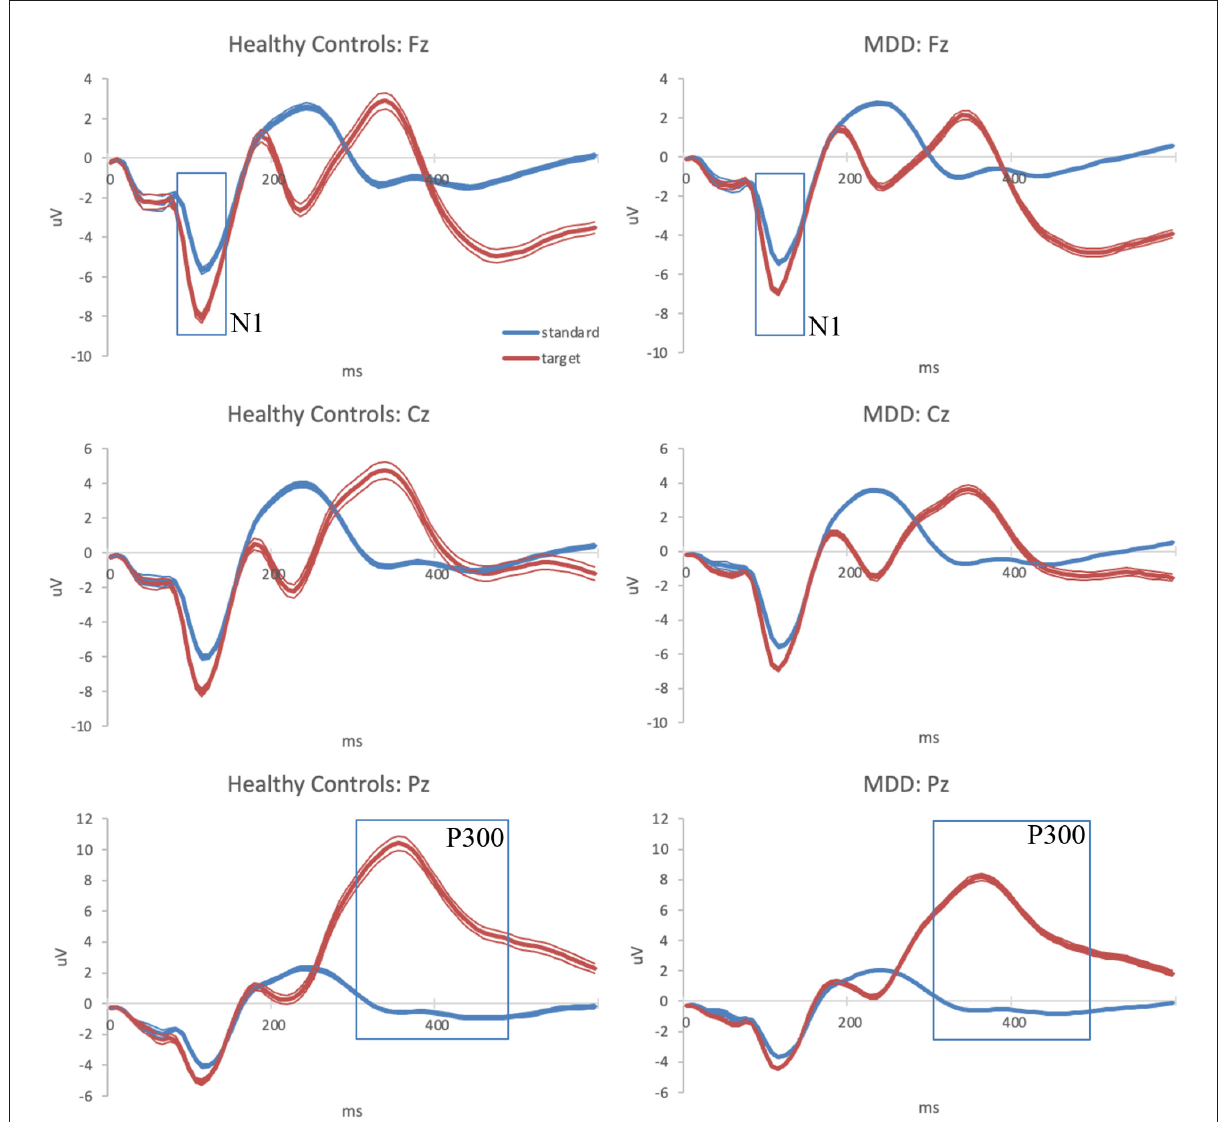
FIGURE1 Grand-average auditory ERPs for standard (blue) and target (red) tones recorded during the baseline visit in healthy controls (left column) and MDD patients (right column) at frontal, central, and parietal midline scalp locations. Standard errors are plotted as thin lines around each waveform. MDD, major depressive disorder; ERPs, event-related